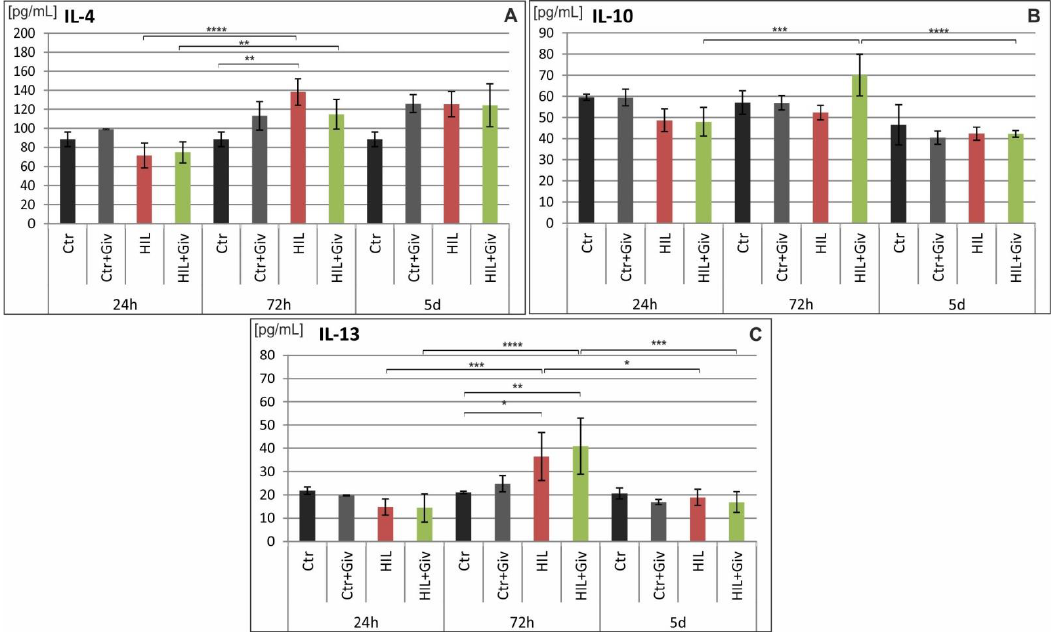
Figure 10. Anti-inflammatory cytokine profile in neonatal rat brains after hypoxia-ischemia. Quantitation of IL-4 ( A ), IL-10 ( B ) and IL-13 ( C ) protein levels detected in the rat brain of control animals and 24 h, 72 h and 5 days after hypoxia-ischemia, treated and untreated with Givinostat. The values are the mean ± SD from five animals per group and time point. One-way ANOVA indicates significant differences between the investigated experimental groups: * p < 0.05; ** p < 0.01; *** p <0.001; **** p < 0.0001.